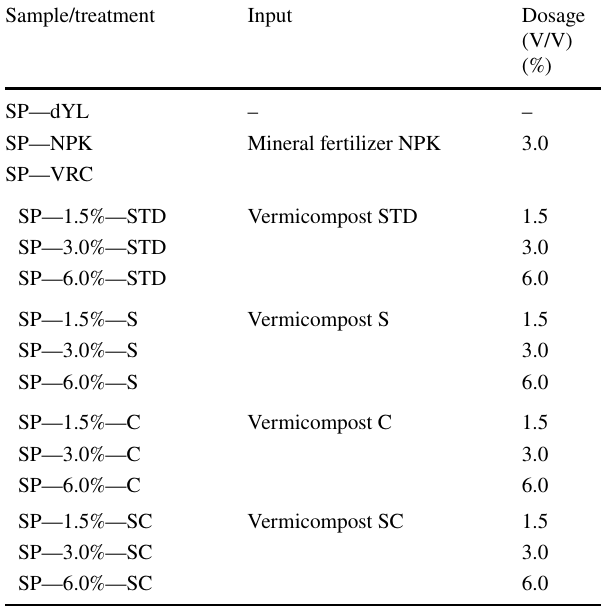
Table 1 Details of samples and different treatments adopted in the